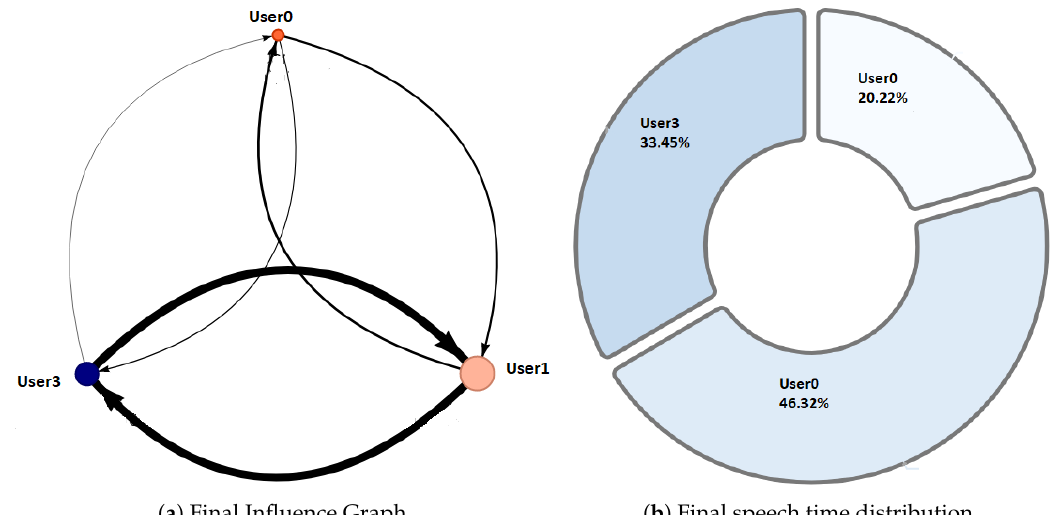
Figure 11. Final Behavior observed in